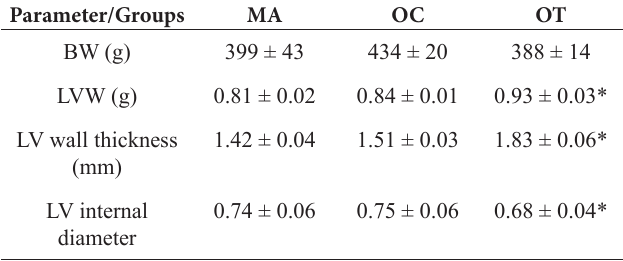
Table 1. Body weight, LV weight, LV wall thickness and LV internal diameter of MA, OC and OT groups of rats.